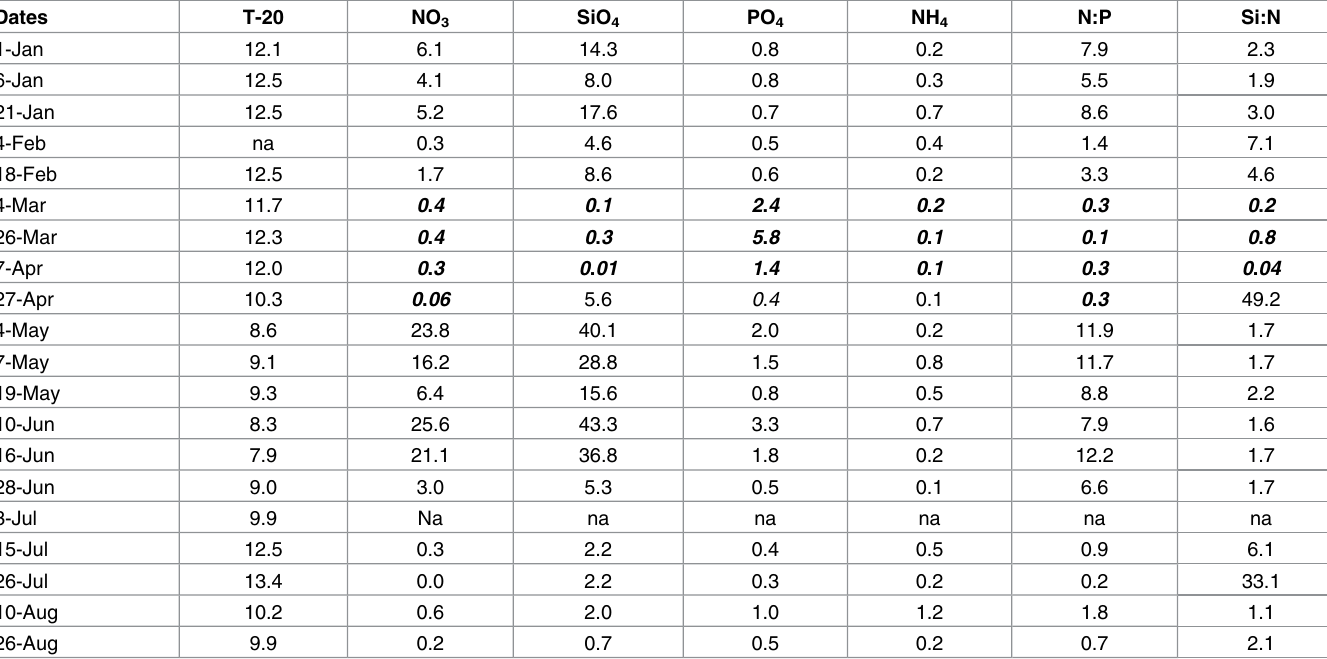
Table 1. Temperature and nutrients at the nearshore station NH5 in